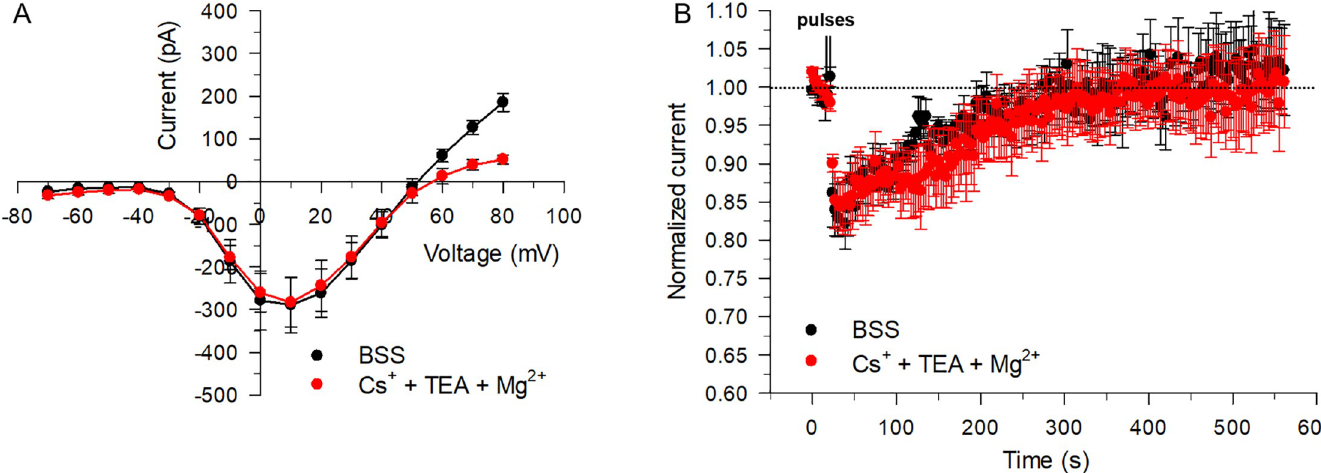
Fig 7. Effect of twin pulses on I Na recorded in K + - and Ca 2+ -free BSS at an E-field of 8 MV/m. (A) Effect of eliminating K + and Ca 2+ currents on the I-V relationship of the early peak inward current. I-V relationships were obtained either in regular BSS (black circles) or in K + - and Ca 2+ -free BSS (Cs + + TEA + Mg 2+ ; red circles). (B) Mean time course of changes of peak I Na recorded with normal (BSS) or Cs + -TEA-Mg 2+ -based solutions in cells exposed to twin pulses (8 MV/m) with a 10 ms interpulse interval. Data are expressed as the mean ± SE (BSS, n = 5; Cs + + TEA + Mg 2+ , n = 6).